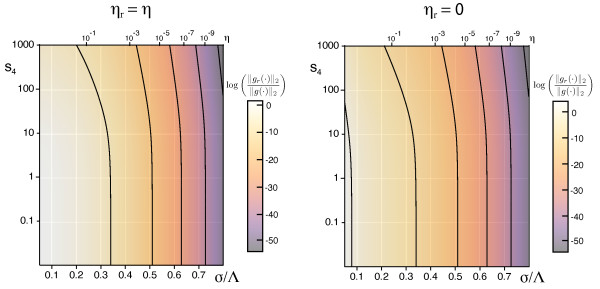
Strength of coupling between orientation map and retinotopy in the EN model. (a) Ratio of ||gr(·)||2/||g(·)||2 in the s4-σ/Λ-plane for the EN model at threshold and η = ηr. (b) As a, but for ηr = 0, i.e., strongest coupling. Note the logarithmic scaling of the colormap.